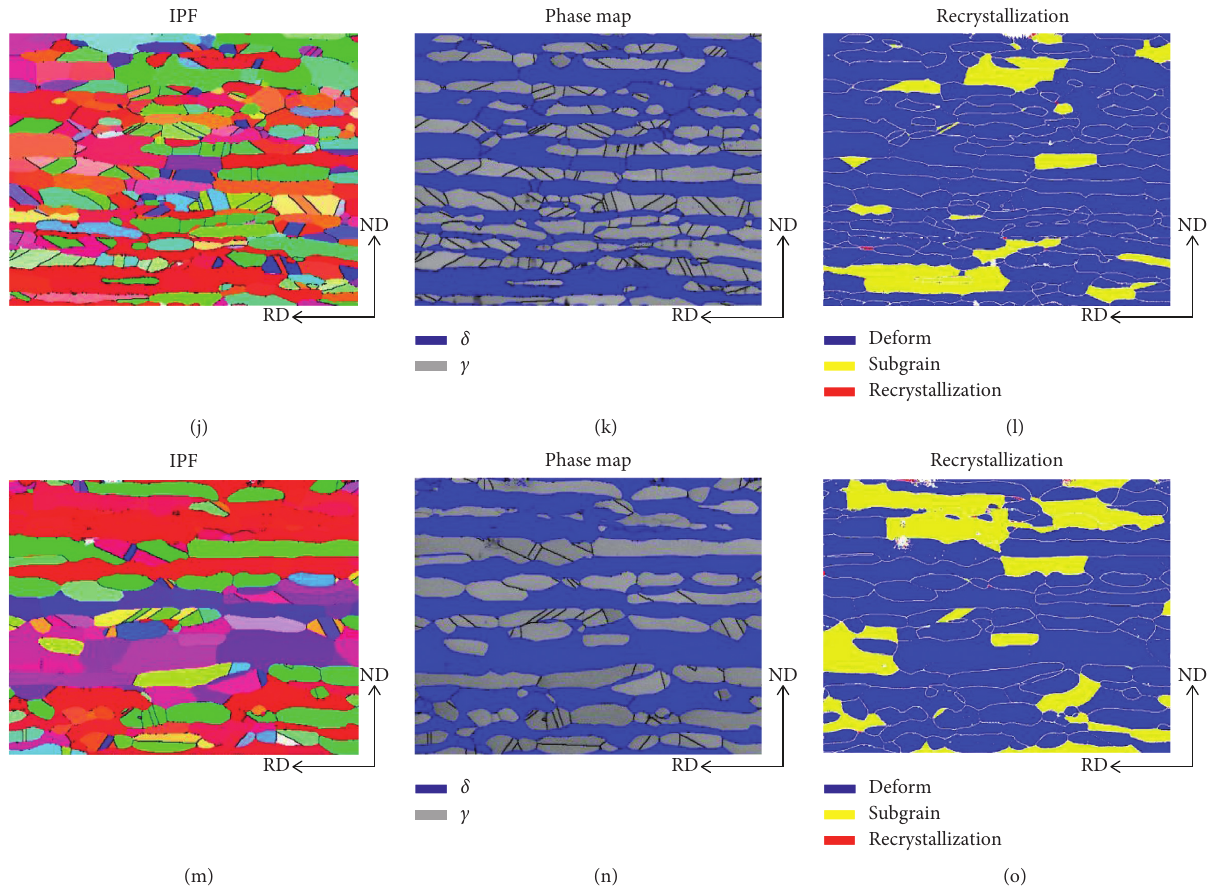
Figure 1: Microstructure of 2205 duplex stainless steel at different solution temperatures: (a–c) 1000 ° C, (d–f) 1040 ° C, (g–i) 1080 ° C, (j–l) 1120 ° C, and (m–o) 1160 ° C.